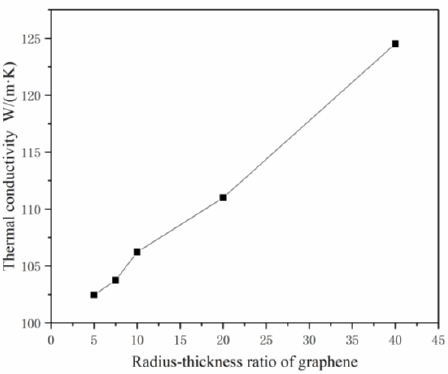
Figure 10. The effects of the diameter–thickness ratio of graphene on K c .